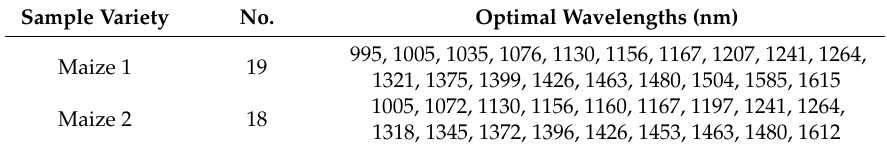
Table 4. Corresponding optimal wavelengths selected by second-order derivative